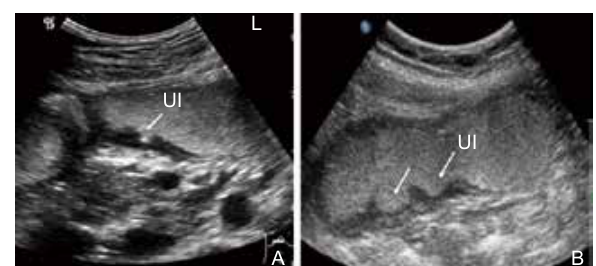
Figure 7 Gastroesophageal reflux. (A) Contrast ultrasound imaging shown a pre-phase of gastroesophageal reflux; (B) Contrast agent appears